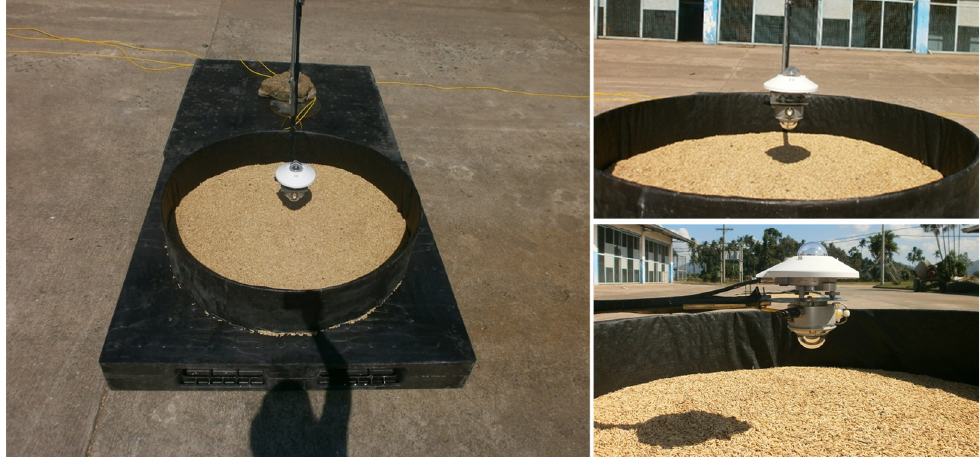
Figure 3. Setup of the pyranometers for measuring albedo at International Rice Research Institute (IRRI) in Los Baños, Republic of the Philippines (14°9′55′′ N, 121°15′37′′ E).